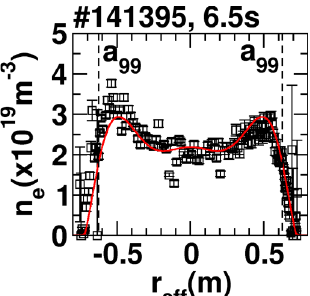
Fig. 4: The electron density profile obtained by Thomson scattering measurement (square) and its polynomial fitted profiles (solid line) plotted versus the effective minor radius “r eff ”. The dashed lines represent the a 99 surface inside which 99% of the electron kinetic energy is included and almost coincides with the